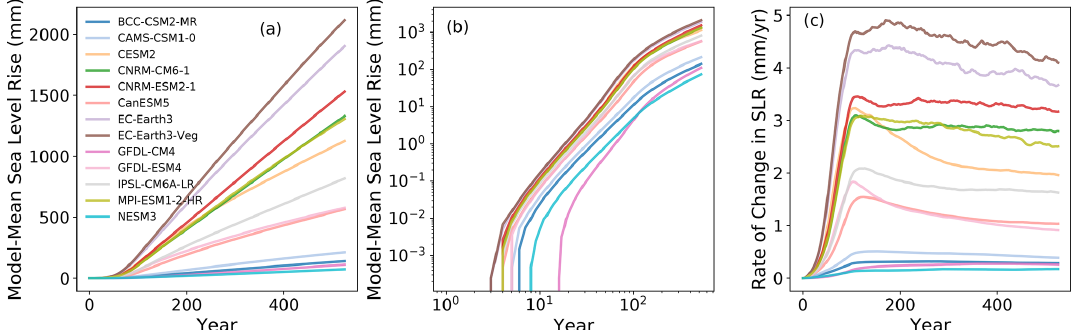
Figure A3. (a) Model-mean sea level rise, (b) model-mean sea level rise on log–log scale and (c) model-mean SLR rate of change (mmyr − 1 ).